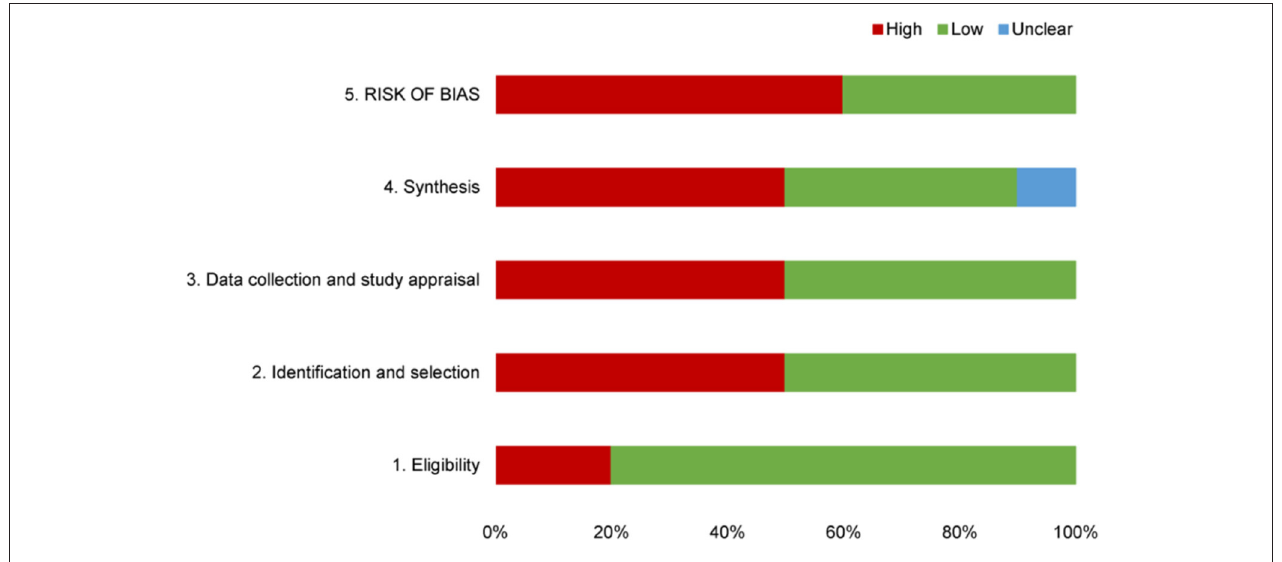
FIGURE 2 | Graphical presentation of risk of bias of the included